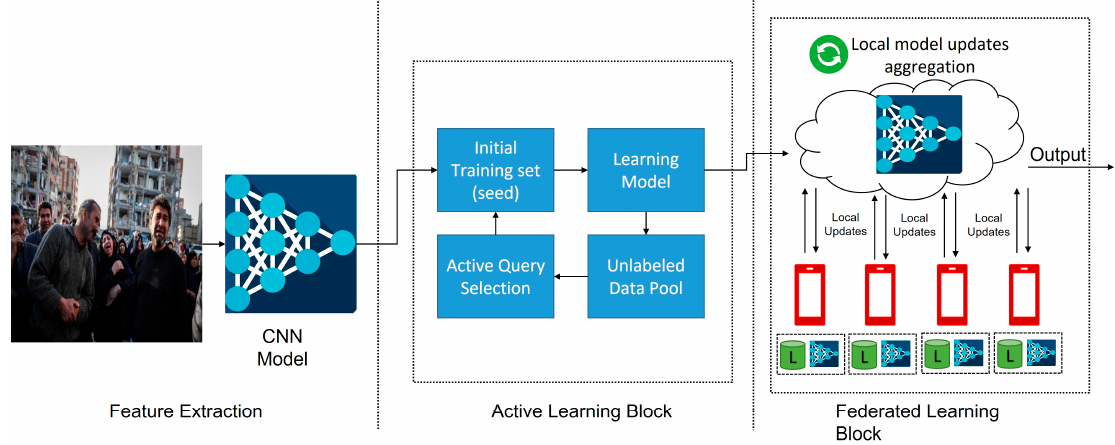
Figure 2. Infographic illustrating the proposed AL-based FL architecture.